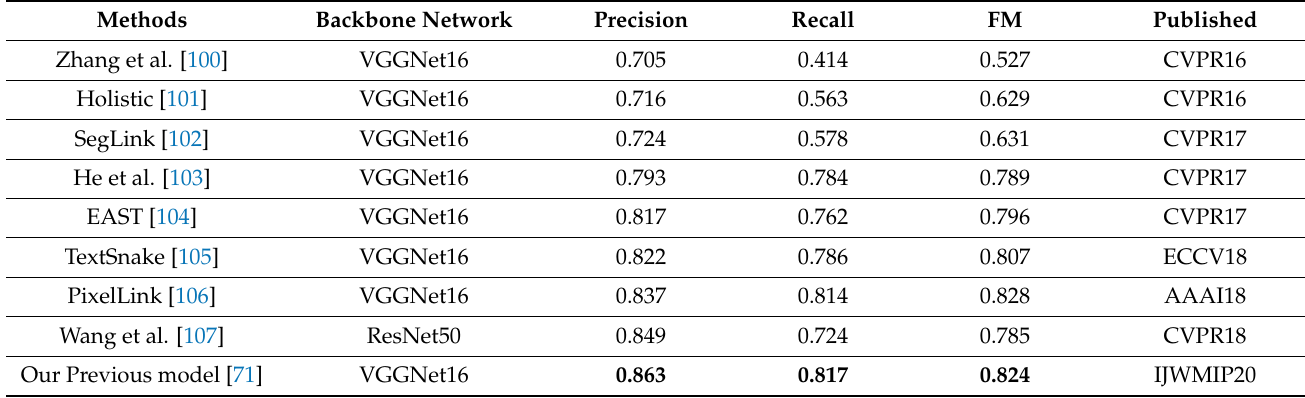
Table 6. The performance comparison of our previous text detection model with other state-of-the-art models on ExDark datasets. The best results are marked in bold. Methods Backbone Network